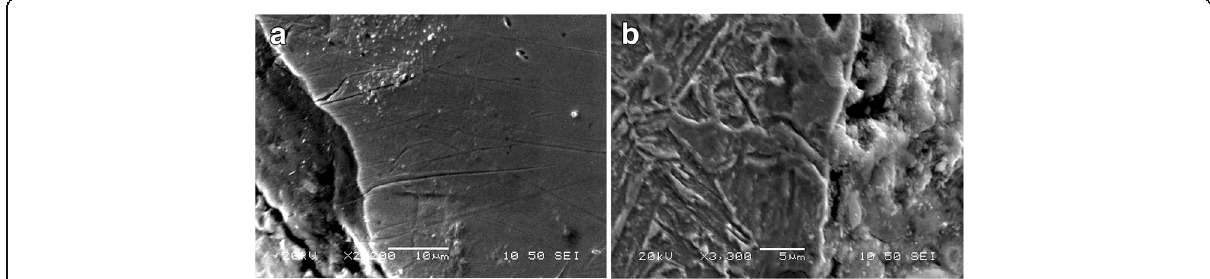
Fig. 6 SEM micrographs of ASTM 514 grade S post-torched steel. a Found defects are different sized micro-cracks into the HAZ, from 15 to 48 μ m. b Microstructural change in the HAZ-bulk interface